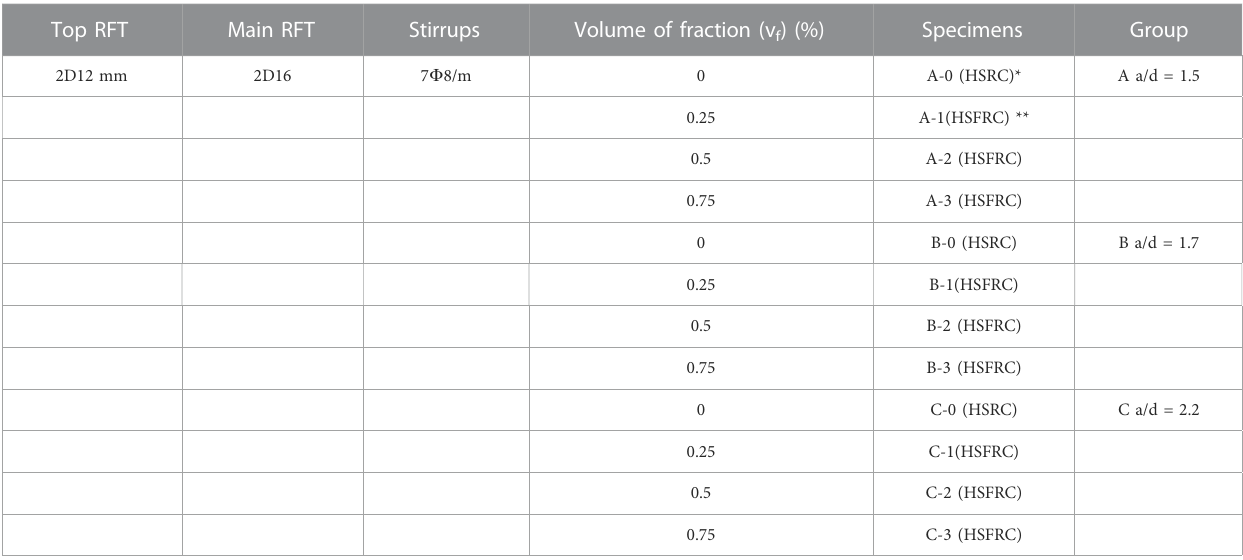
TABLE 5 Overview of tested